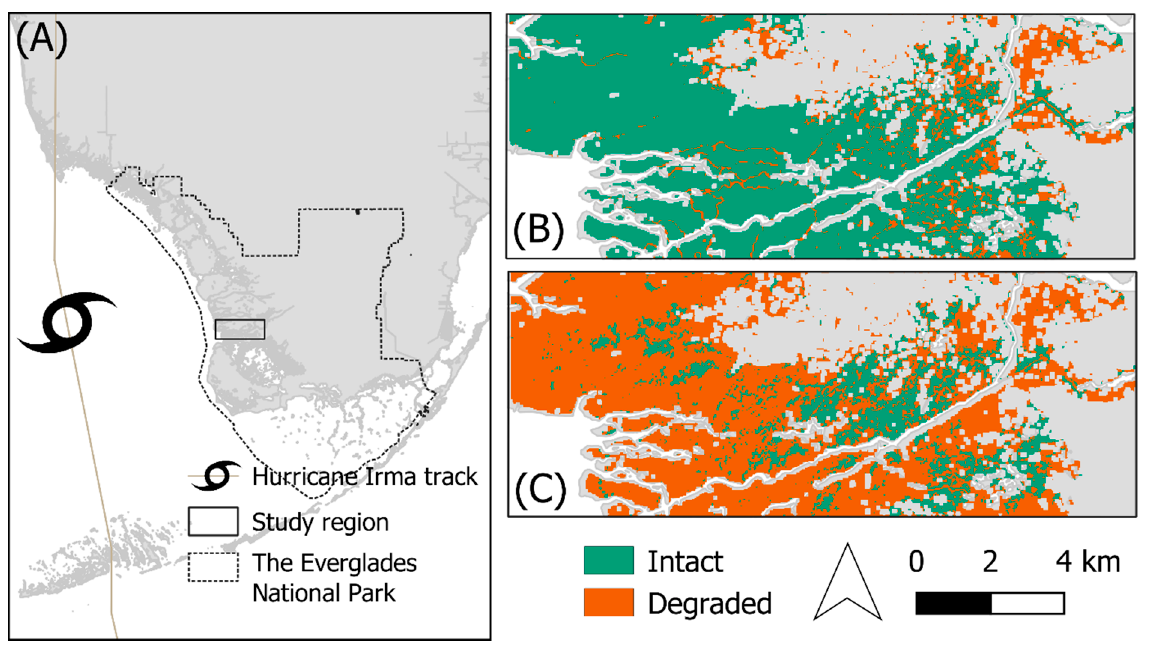
Figure 5. Mapped mangrove degradation for the Shark River case-study region. ( A ) Location of Shark River study region within the Everglades National Park, showing Hurricane Irma’s track ( B ) Results of the degradation model for pre-Hurricane Irma (2016–2017) and ( C ) Post-Hurricane Irma (2017–2018).